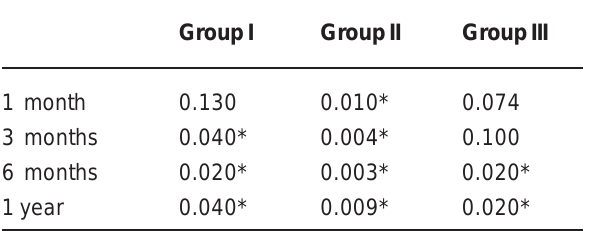
TABLE 3- Analysis within groups for the presence of TMJ painful sites to palpation (“p” values)